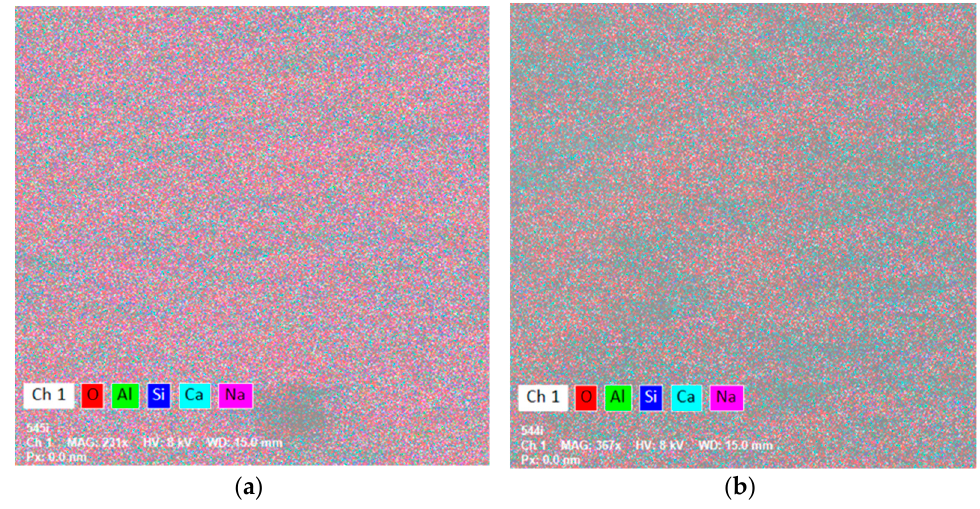
Figure 8. Surface mapping of ( a ) CP and ( b ) CP10VSW samples at high magnification.